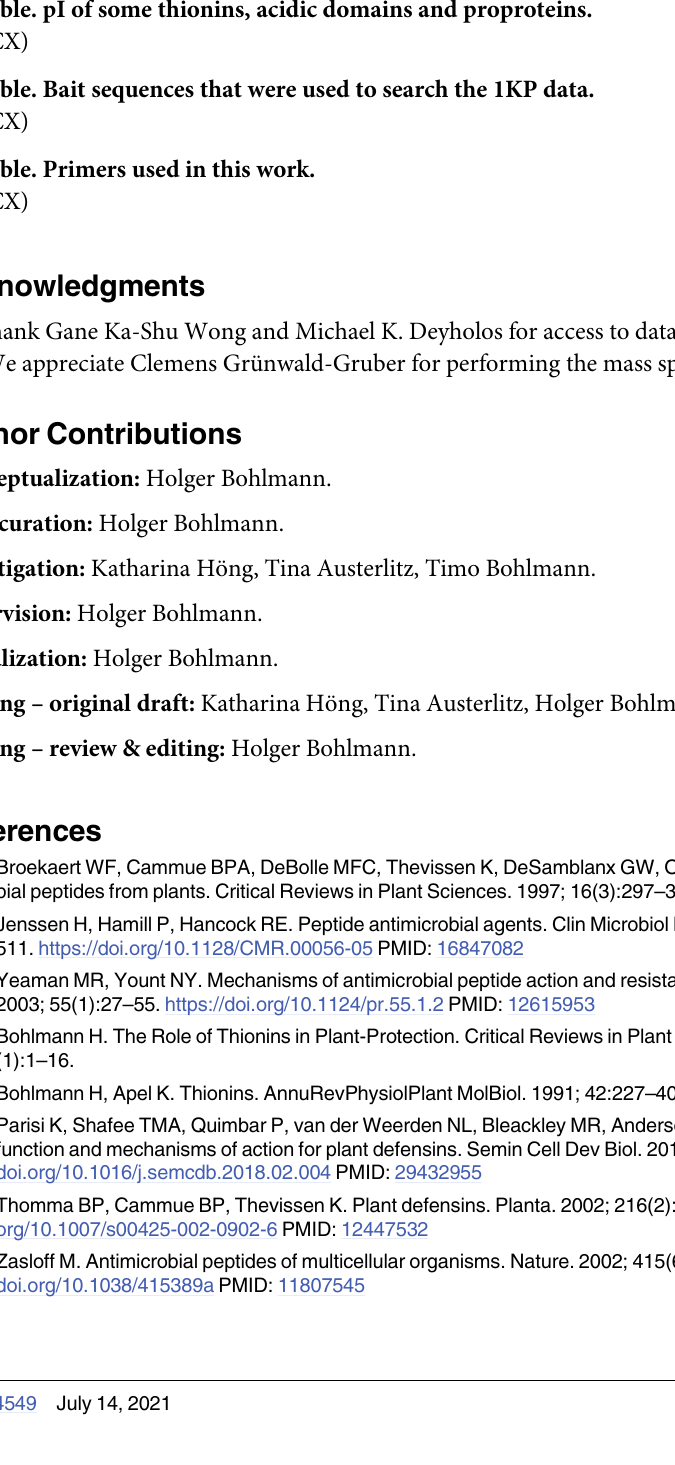
S1 Fig. Sequences of different thionin proproteins. S2 Fig. General structure of thionin preproproteins and position of the introns. S3 Fig. Expression and purification of PsoTHI1.7. S1 Table. pI of some thionins, acidic domains and proproteins. S2 Table. Bait sequences that were used to search the 1KP data. S3 Table. Primers used in this